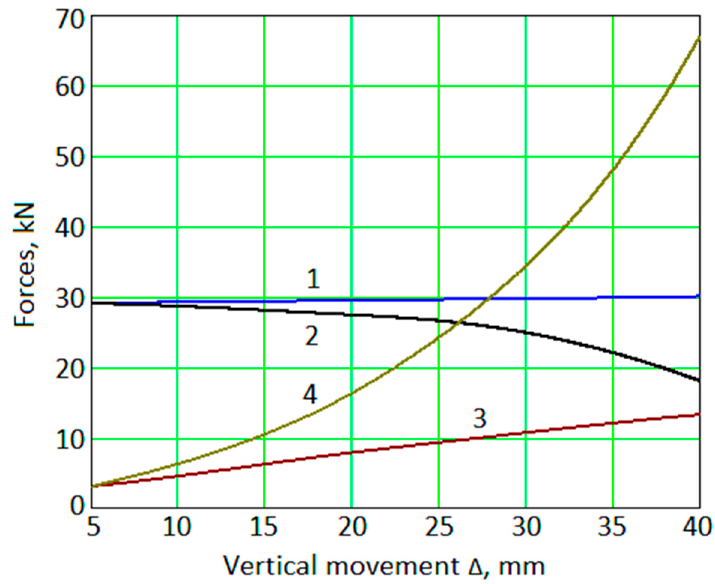
Figure 6. Dependencies of forces Q k and F npk [kN] on the pressure disc (1,2) and spring (3,4) on the vertical movement Δ [mm] of the carriage: 1— F np 1 ; 2— Q 1 ; 3— F np 2 ; 4— Q 2 .